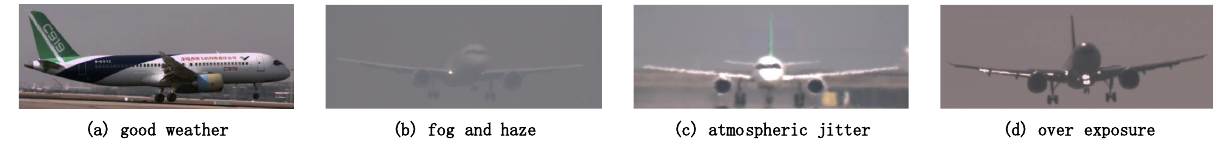
Figure 3. Complex weather scenes during the aircraft flight. As shown in ( a ), the weather is good, and the aircraft in the image is clear. As shown in ( b ), severe fog and haze blur the aircraft in the image. As shown in ( c ), the atmospheric jitter in the camera imaging process makes it hard to recognize the keypoints precisely. As shown in ( d ), over exposure causes a lack of texture